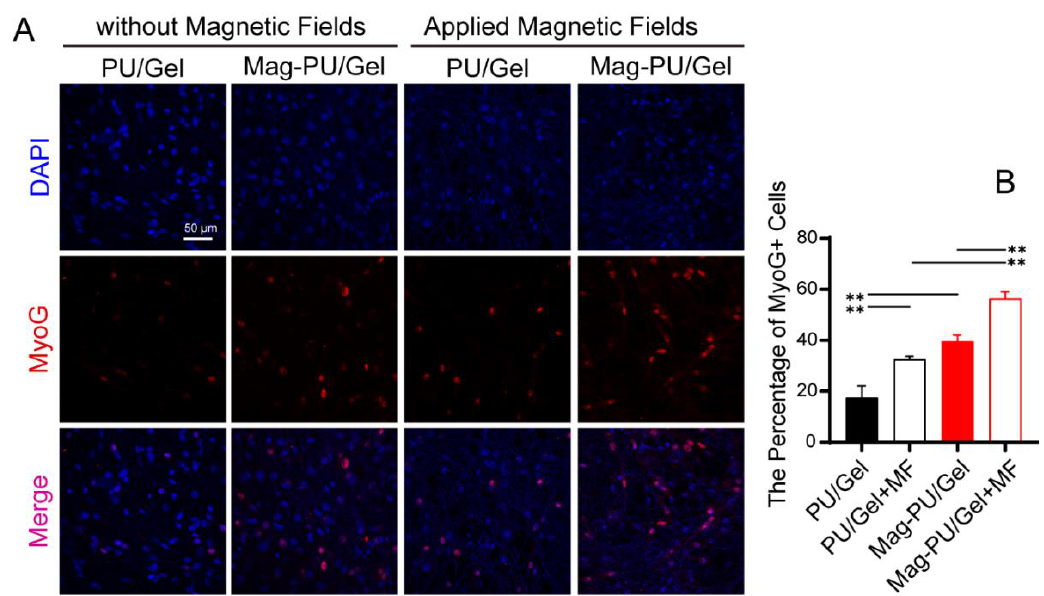
Figure 3. Effects of magnetic scaffolds and magnetic fields on the expression of MyoG. ( A ) Immunofluorescence staining of MyoG protein in C2C12 cells after incubation under different conditions for 7 days, MyoG positive cells were stained as red, and nuclei were stained as blue. ( B ) Percentage of MyoG positive cells in different groups. These data were analyzed by one-way analysis of variance with Tukey’s post hoc test : ** p < 0.01. * indicated significant difference.